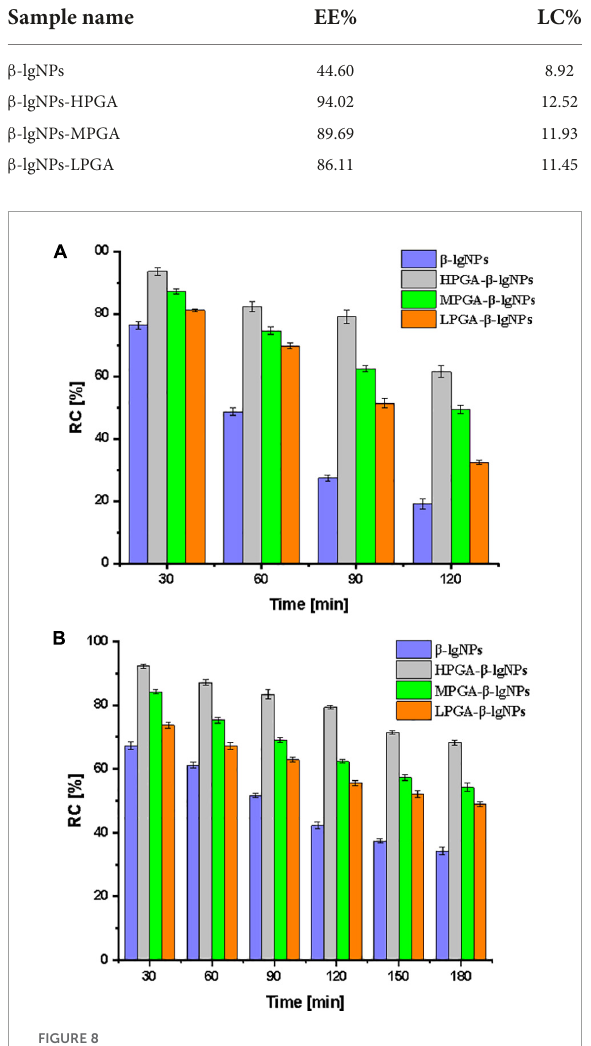
FIGURE8 Relatively content (RC%) of curcumin in PGA- β -lgNPs complexes during the exposure of UV light for 120 min (A) and heat treatment for 180 min (B) .